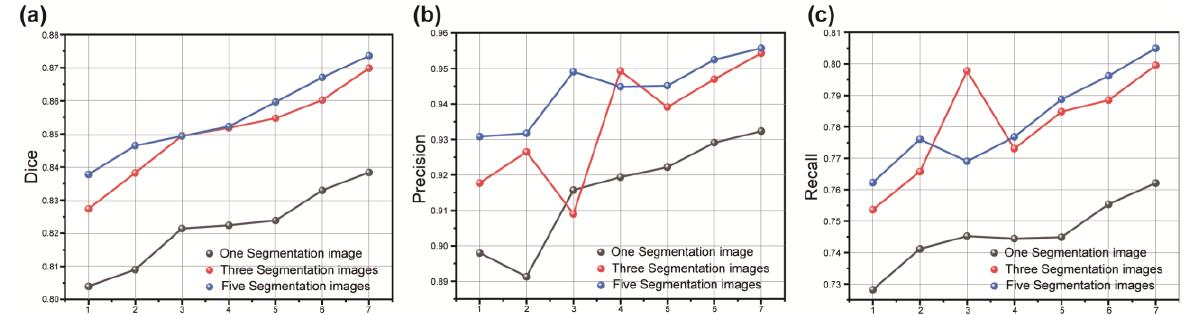
Figure 8. Registration ability of different numbers of segmented labels on the MRbrain dataset (( a – c) are the line graphs formed by the model under the three evaluation metrics of Dice, Preciaion, Recall respectively).